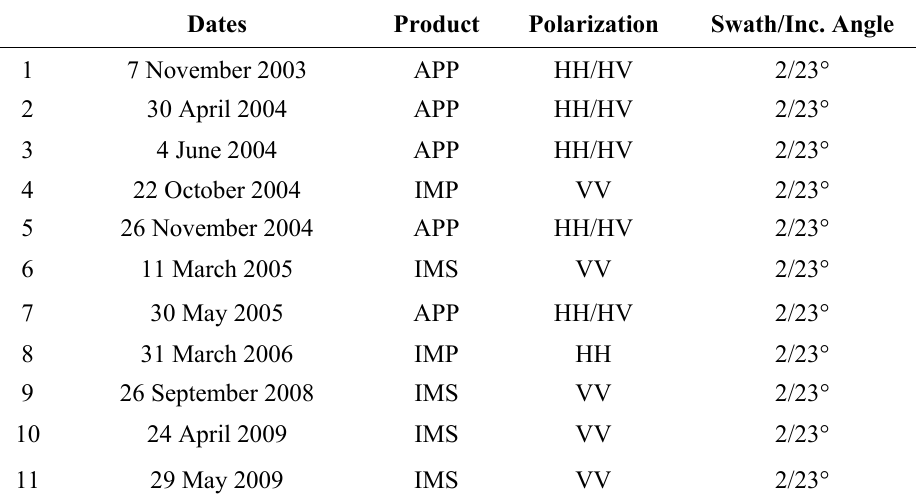
Table 1. ENVISAT/ASAR acquisitions over the Scrivia test site (APP: Alternate Polarization Precision Image, IMP: Image Mode Precision, IMS: Image Mode Single Look